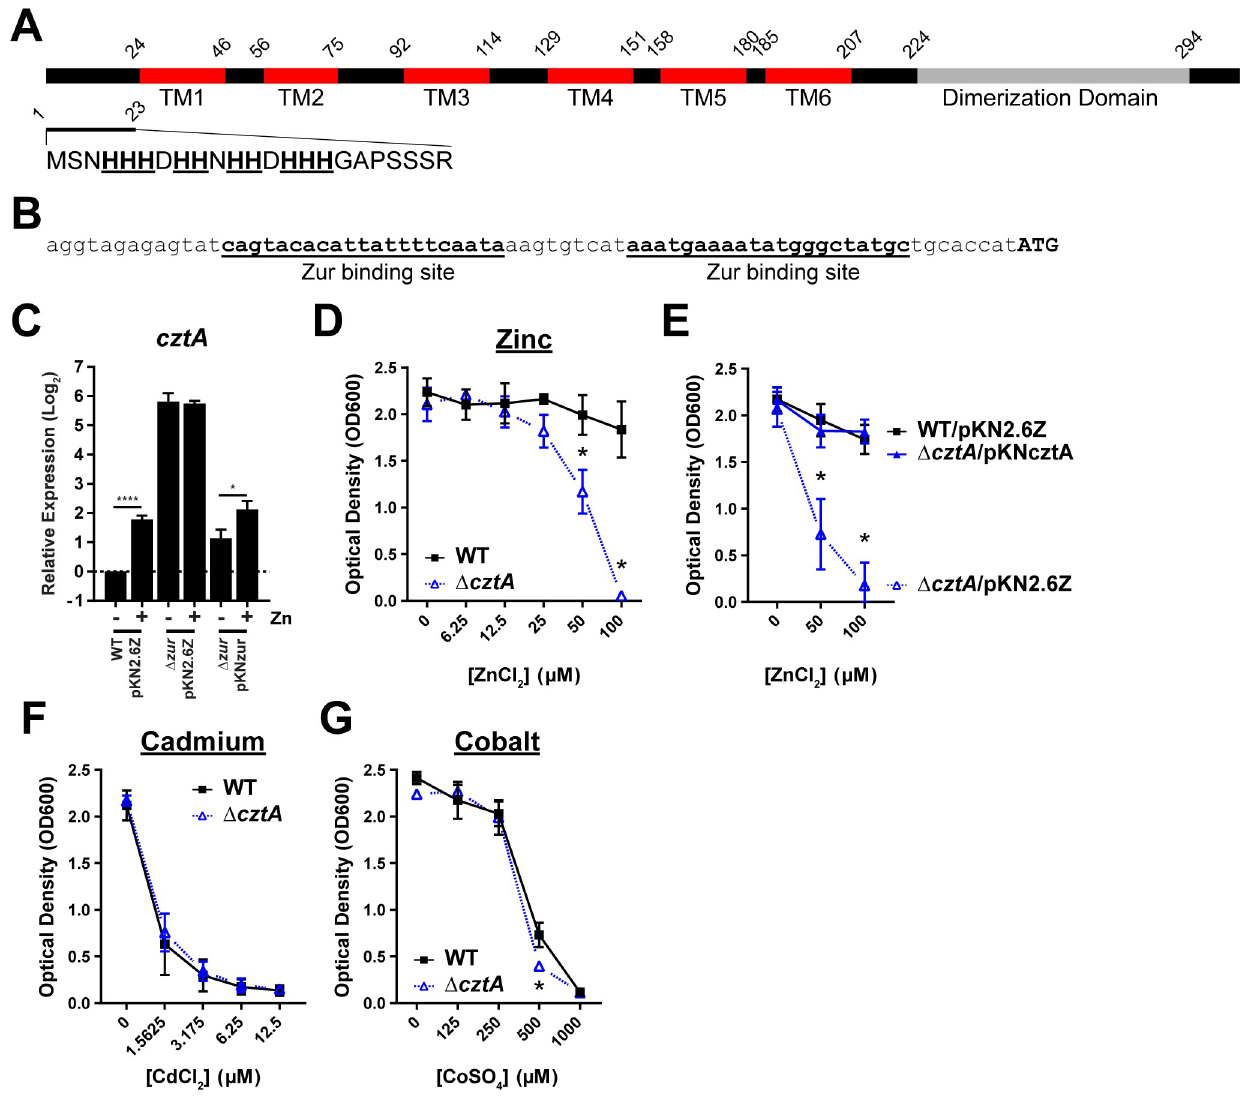
Fig 7. DIP1101 (CztA) encodes a membrane protein involved in zinc tolerance. (A) Structural map of the CztA protein shows multiple transmembrane domains (TM1-6), as predicted by TMHMM [27], and a dimerization domain. N-terminal amino acids 1 to 23 with histidine residues underlined; amino acids 18 to 294 share similarity with proteins of the COG1230 family of cation efflux membrane proteins. (B) Locations of verified Zur binding sites relative to the start codon (ATG) of CztA. (C) Expression of cztA tested by RT-qPCR in wild-type C . diphtheriae carrying vector pKN2.6Z (WT pKN2.6Z) and the zur mutant with vector pKN2.6Z ( Δ pKN2.6Z) or the zur complementing plasmid, pKNzur ( Δ pKNzur) without ( - ) or with ( + ) zinc supplementation. The data are the mean and standard deviation of three biological replicates. Expression of the gyrB gene was used for normalization; significance was determined by 2way ANOVA, Holm-Sidak’s multiple comparisons test: ���� indicates p < 0.0001; � indicates p < 0.05. (D) Growth of C . diphtheriae wild type (WT) and cztA mutant ( Δ cztA ) in HIBTW with zinc chloride supplementation as indicated. (E) Growth of wild-type C . diphtheriae with empty vector (WT/pKN2.6Z) and the cztA mutant with empty vector ( Δ cztA /pKN2.6Z) or cztA complementing plasmid ( Δ cztA /pKNcztA). Growth of the wild type and cztA were also tested with (F) cadmium chloride and (G) cobalt sulfate. The data for growth assays are the mean and standard deviation of at least three biological replicates. � indicates significance by t-test comparing the respective wild type and mutant; p < 0.01.